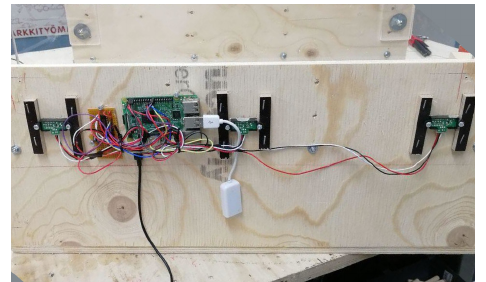
Figure 4. Measures of the tunnel prototype.